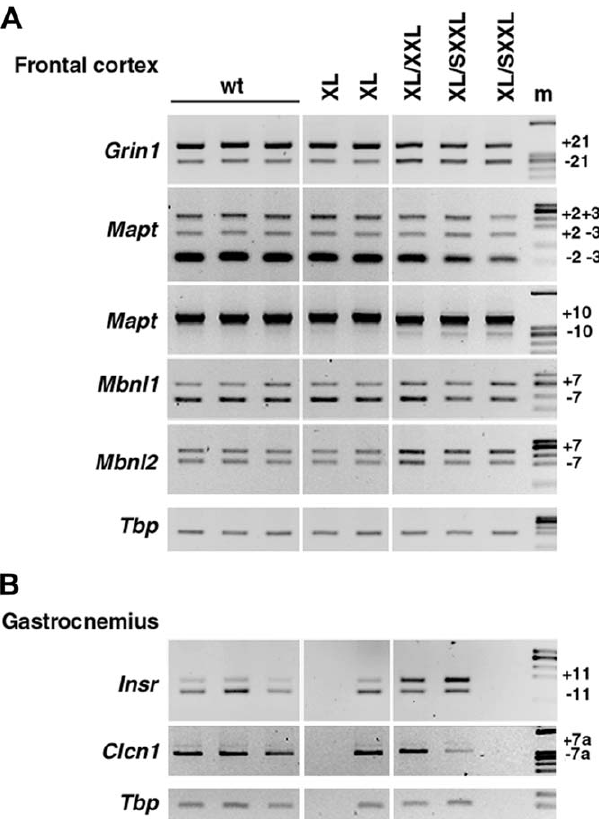
Figure 3. Abnormal RNA Splicing in Homozygous Mice Carrying over 600 CTG Trinucleotide Repeats on Both Alleles (A) Splicing abnormalities in the central nervous system. Abnormal splicing patterns were detected in the frontal cortex of 4-wk-old homozygous female mice ( n ¼ 3), when compared to wild-type ( n ¼ 3) and hemizygous female controls ( n ¼ 2) for mRNA transcripts of Grin1 (favored exon 21 skipping), Mapt (altered splicing patterns of exons 2 and 3, and favored exon 10 skipping), Mbnl1 (favored exon 7 inclusion), and Mbnl2 (favored exon 7 inclusion). Splicing abnormalities were also observed in the hippocampus and striatum (unpublished data). (B) Splicing abnormalities in skeletal muscle. Reverse transcription-PCR experiments showed mRNA splicing defects for Insr (favored exon 11 inclusion) and Clcn1 (modification in the ratio and quantity of þ /– exon 7a isoforms) in the gastrocnemius muscle of 4-wk-old homozygous female mice ( n ¼ 2) when compared to wild-type ( n ¼ 3) and hemizygous female controls ( n ¼ 1). m, DNA molecular weight marker; wt, wild-type; XL, 600–700 CTG; XXL, 900-1000 CTG; SXXL, . 1200 CTG.